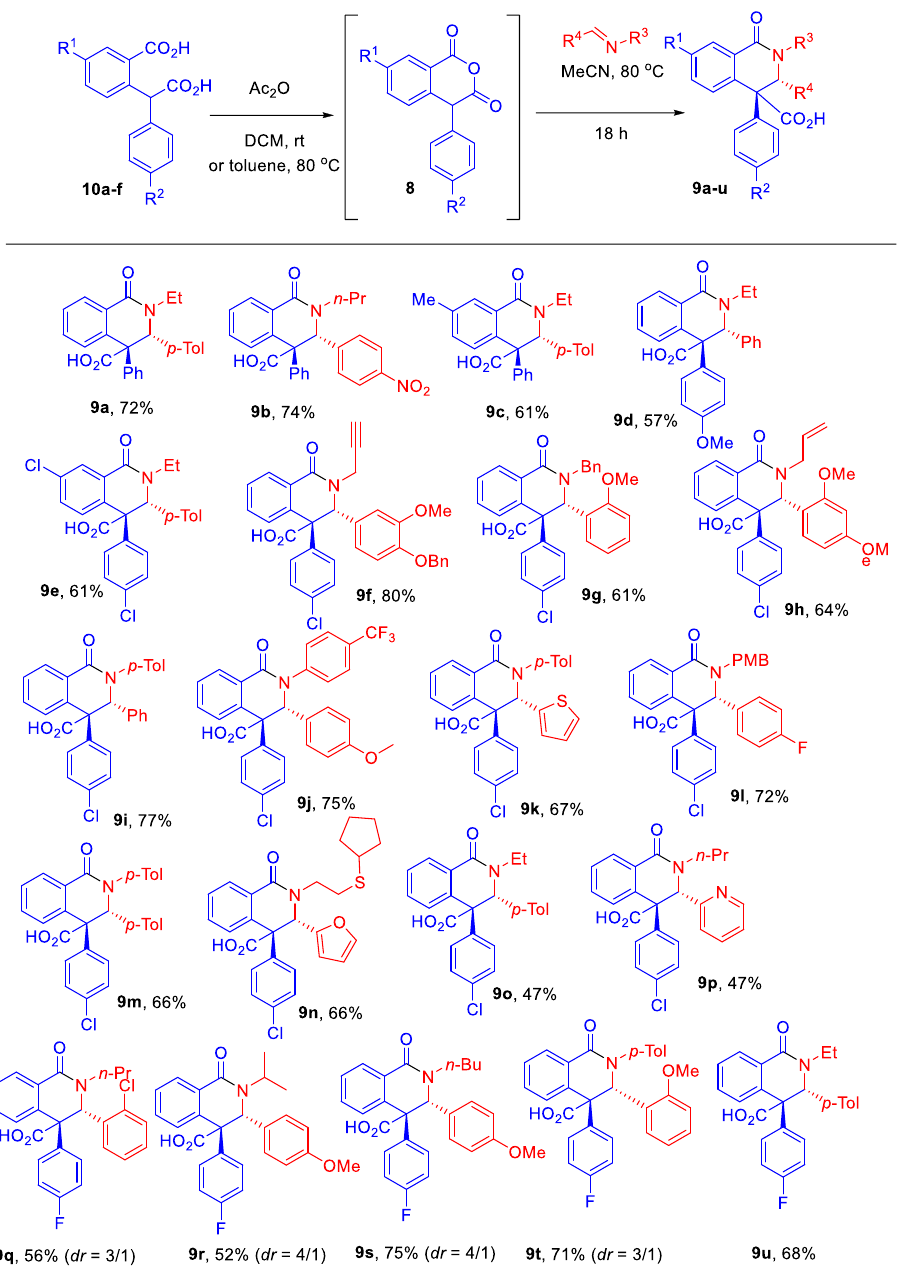
Scheme 2. The CCR of cyclic anhydrides 8 with imines.